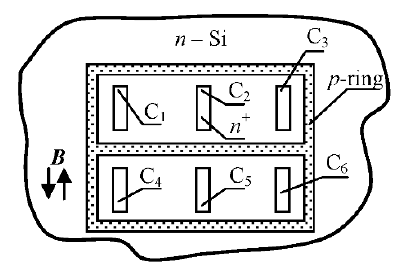
Figure 2. Top-view of the Hall